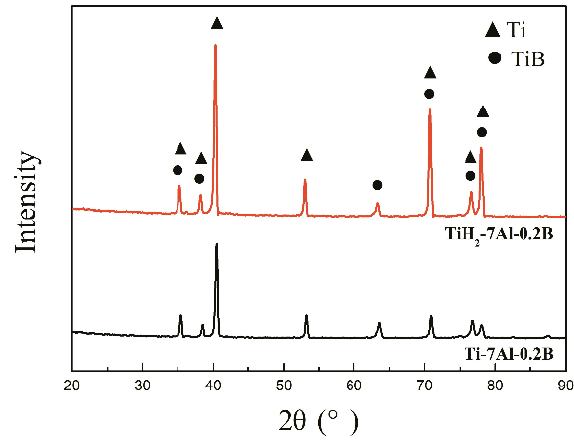
Figure 5. XRD pattern of the sintered alloy.